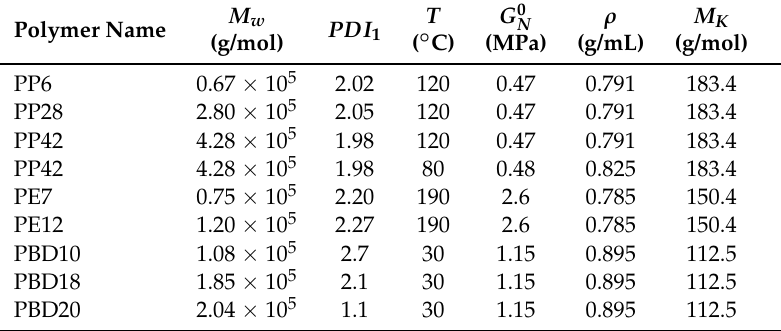
Table 1. Properties of the polymer melts studied in this work. PP and PE melts were produced and characterized in the ExxonMobil facilities. Properties of the PBD samples were already reported by Ruymbeke et al. [23]. In addition, we include the plateau modulus, density and molar mass of a Kuhn step, as given in Ref. [24] for samples at similar